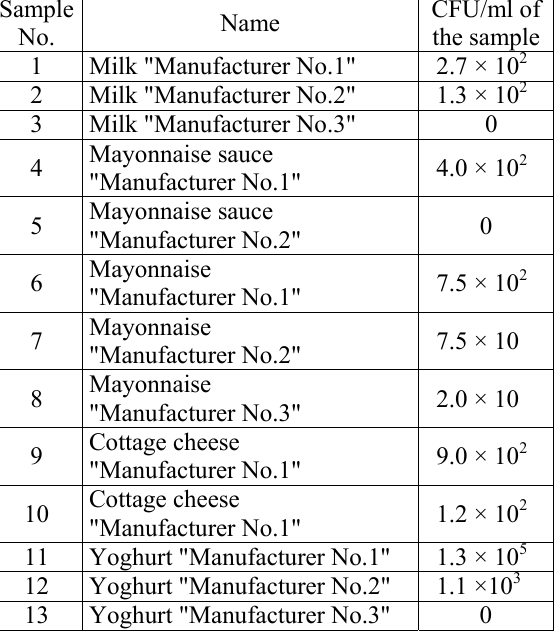
Table 2. Number of microorganisms from the studied